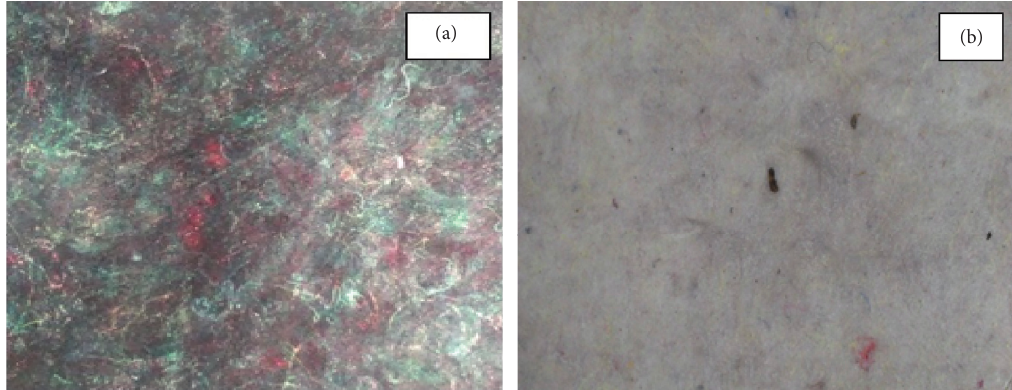
Figure 2: (a) Color and (b) white adhesive-bonded nonwoven recycled cotton/polyester